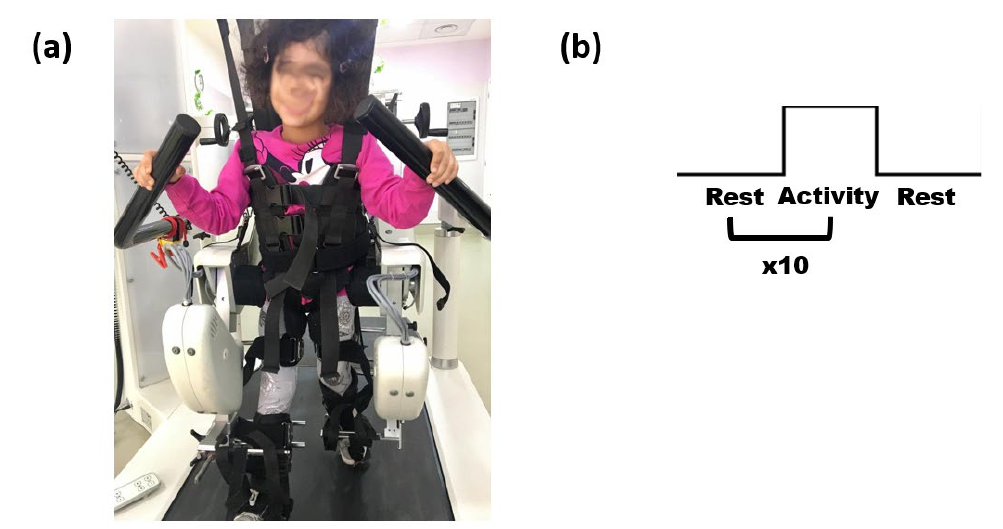
Figure 1. ( a ) Representative participant tethered to the Lokomat. Once the participants were harnessed on the exoskeleton for the robotic therapy, the thermal camera was placed to focus on the participant’s face. ( b ) Representation of the block designed paradigm employed for the experimental sessions. The block design paradigm allowed to administer the RAGT in an ecological way and to evaluate the temperature changes during the walking phases with respect to a rest period. Notably, 10 blocks were considered in the experiment; hence, 10 temporal windows were analyzed for each patient.